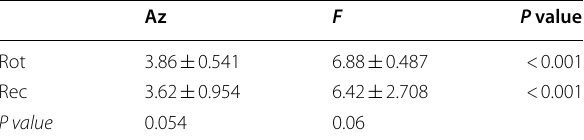
Table 1 Displaying means and standard deviation of weight loss recorded in milligrams for Azure and Fanta AF One rotary files in rotation and reciprocation